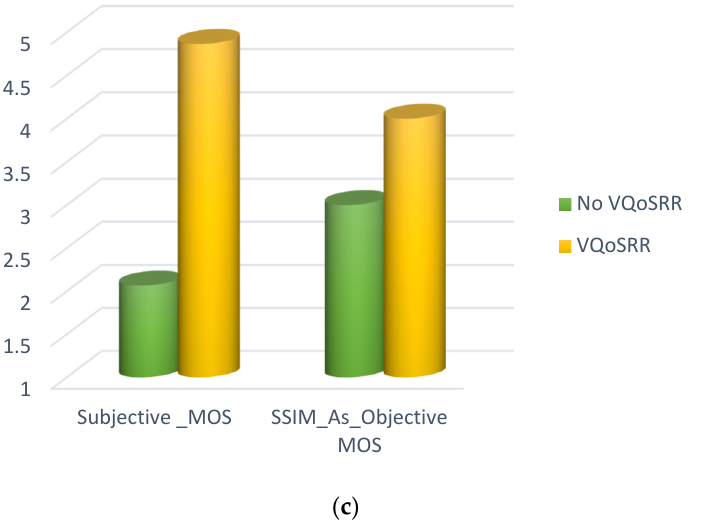
Figure 14. Comparison between subjective and objective metrics QoE. ( a ) For BE class service; ( b ) for SD class service; ( c ) for HD class of service.